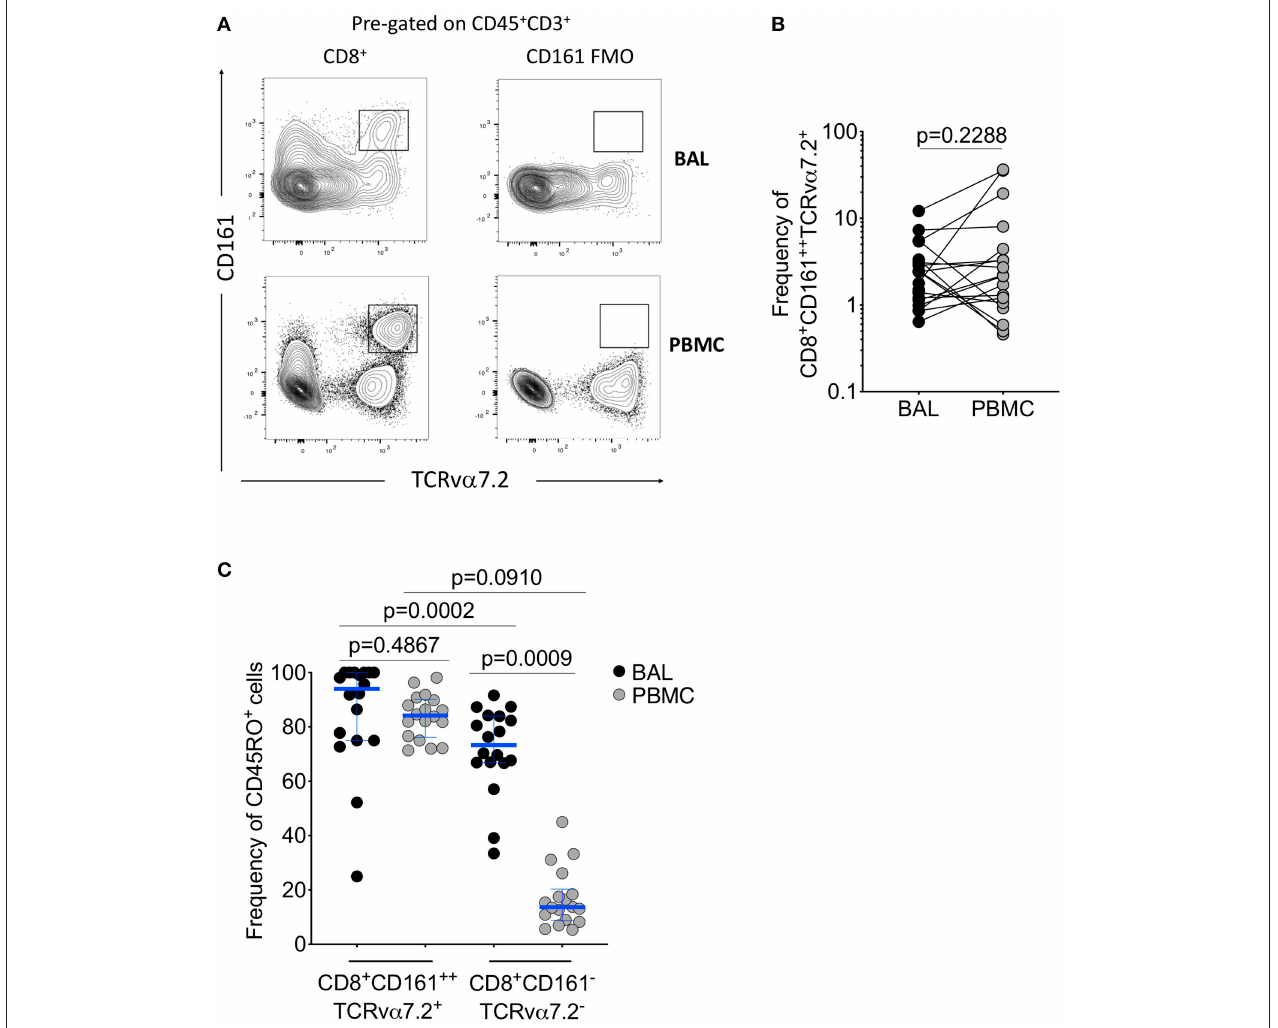
FIGURE 1 | Identification of CD8 + CD161 ++ TCRv α 7.2 + T cells in airway lumen and peripheral circulation. BAL cells and PBMCs from HIV-uninfected adults were stained with fluorochrome-conjugated antibodies against surface markers of interest. (A) Representative flow cytometry plots showing CD8 + CD161 ++ TCRv α 7.2 + T cells in matched BAL and PBMC samples from a healthy HIV-uninfected adult. (B) Frequency of CD8 + CD161 ++ TCRv α 7.2 + T cells in BAL compared to blood. (C) Memory phenotype of CD8 + CD161 ++ TCRv α 7.2 + T cells in BAL compared to blood. Data were analyzed using Wilcoxon matched-pairs signed rank test ( n = 20). BAL, bronchoalveolar lavage; PBMC, peripheral blood mononuclear